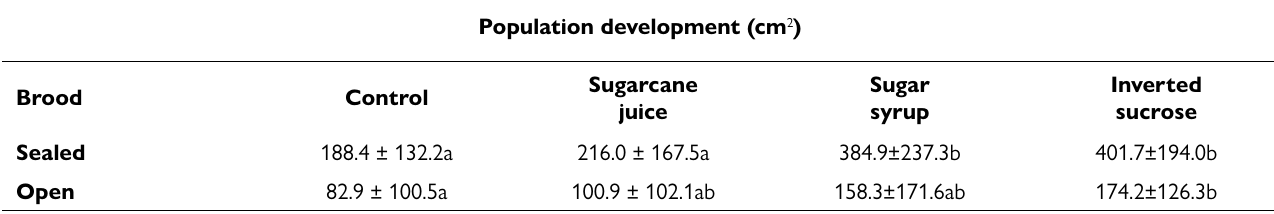
Table 4. Mean and standard deviation of the open and sealed (cm 2 ) brood area in relation to the treatments control, sugarcane juice, sugar syrup and inverted sucrose, throughout the experimental